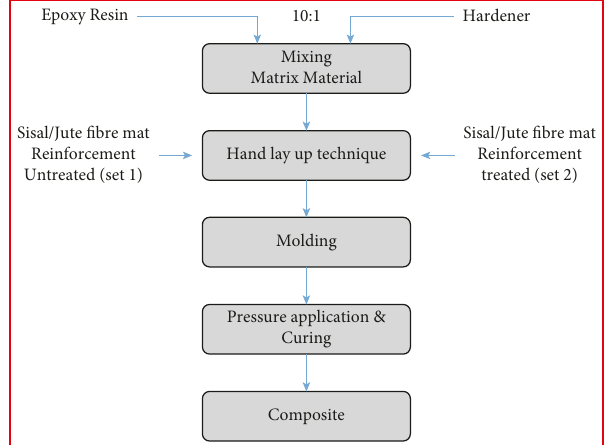
Figure 2: Flowchart of Composite